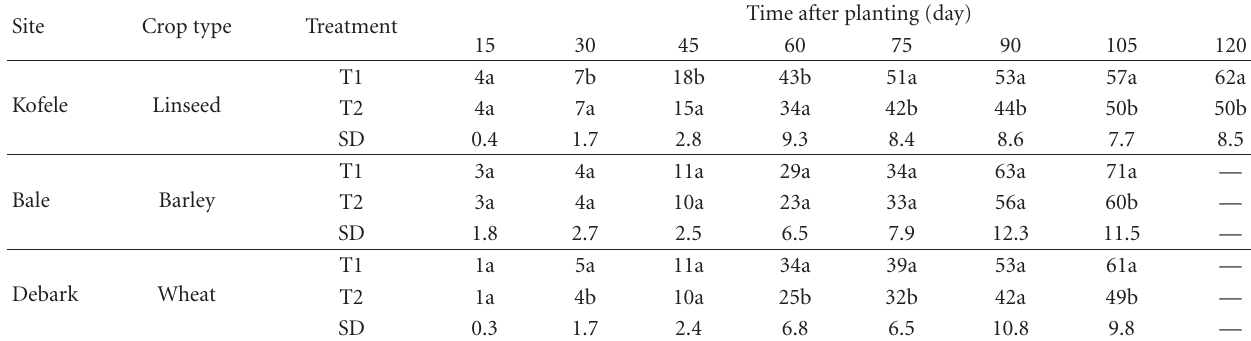
Table 1: Plant height (cm) of indicator plants.